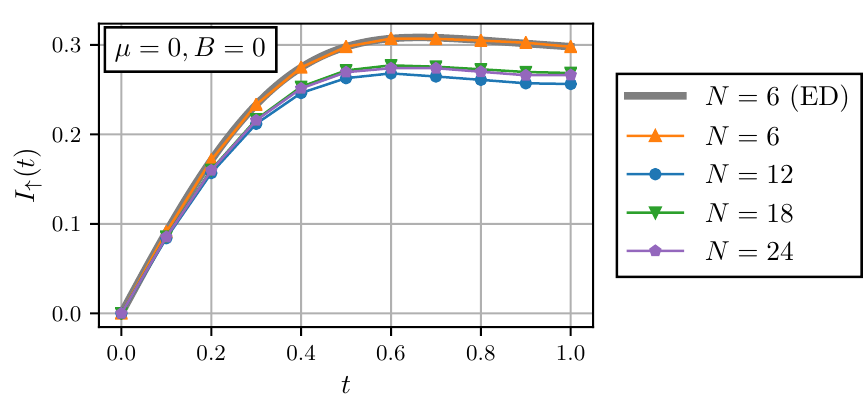
Figure 3: Spin-up current in the half-filled paramagnetic case for various bath sizes N